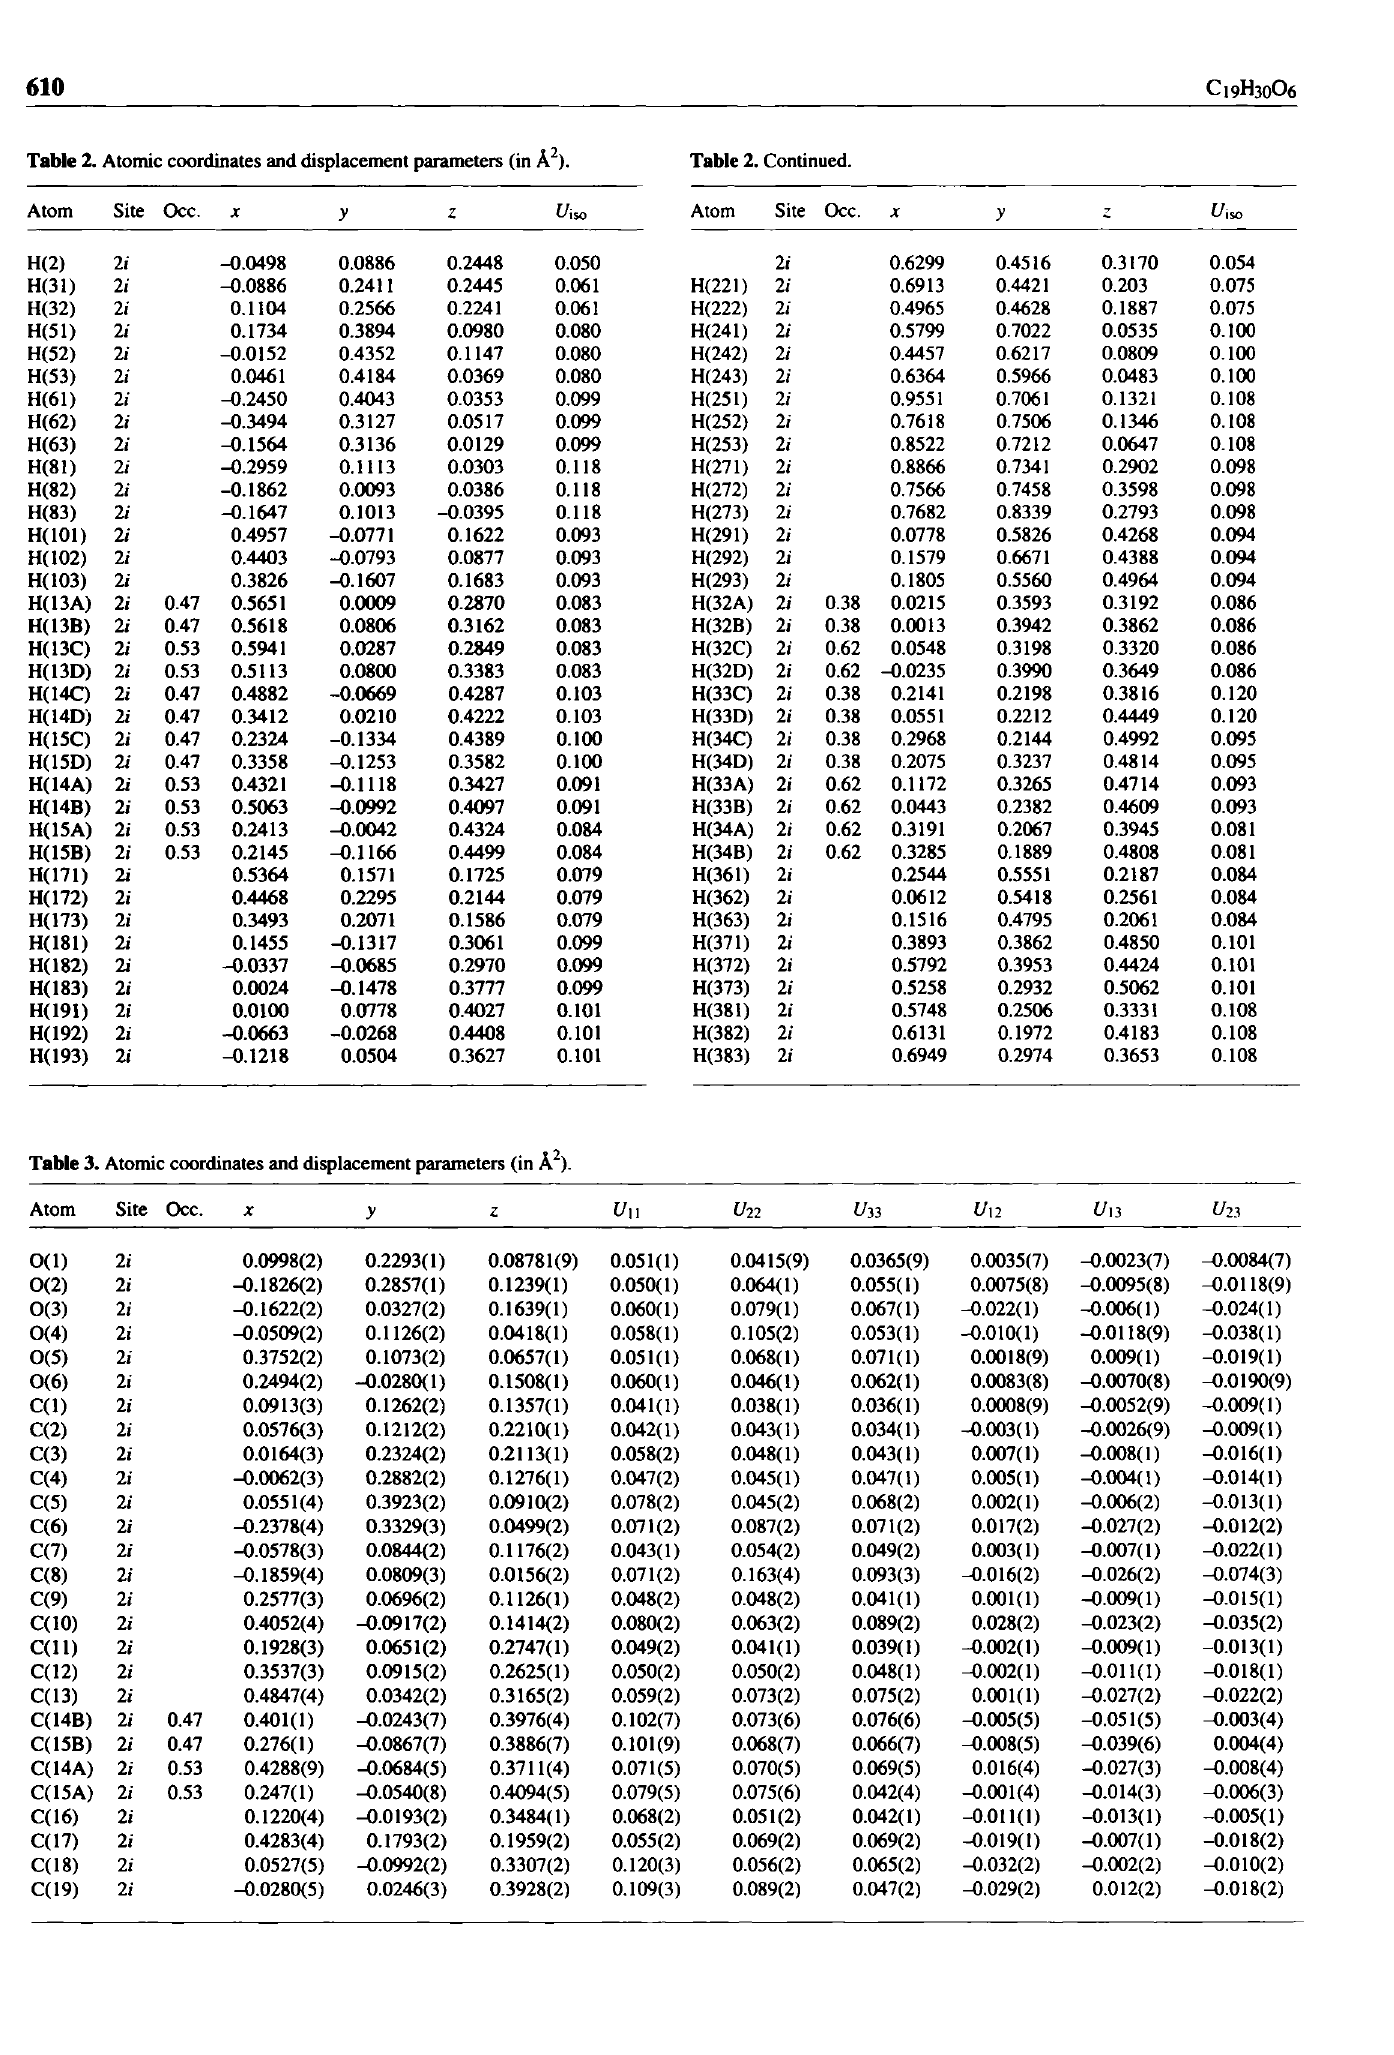
Table 3. Atomic coordinates and displacement parameters (in Ä 2